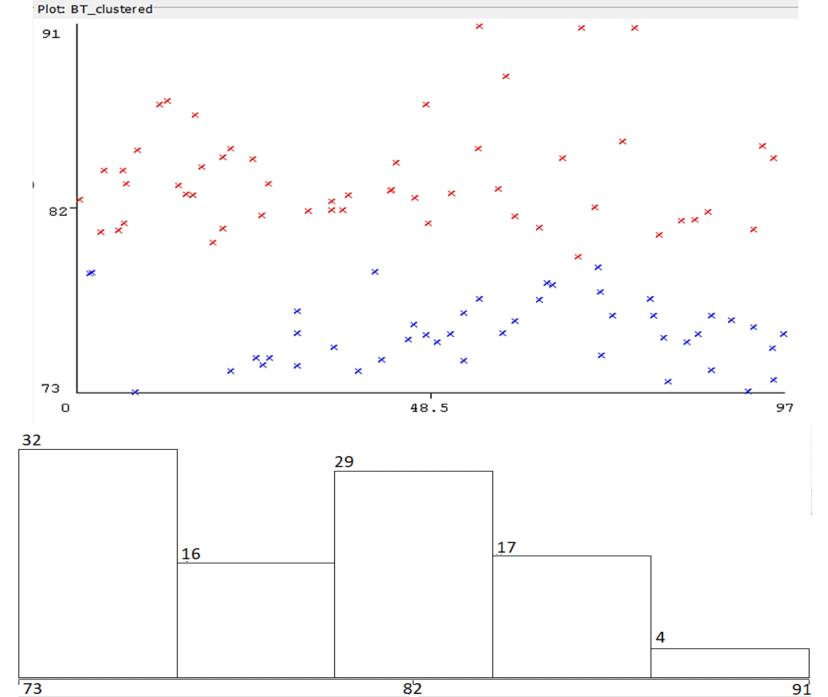
Figure 26. Dispersion of received signal strength recorded levels, with the BT source behind a wall of concrete (NLoS), 2 m distance (horizontal axis—level [dBm], vertical axis: number of receptions). The colors represent belonging to the different classified